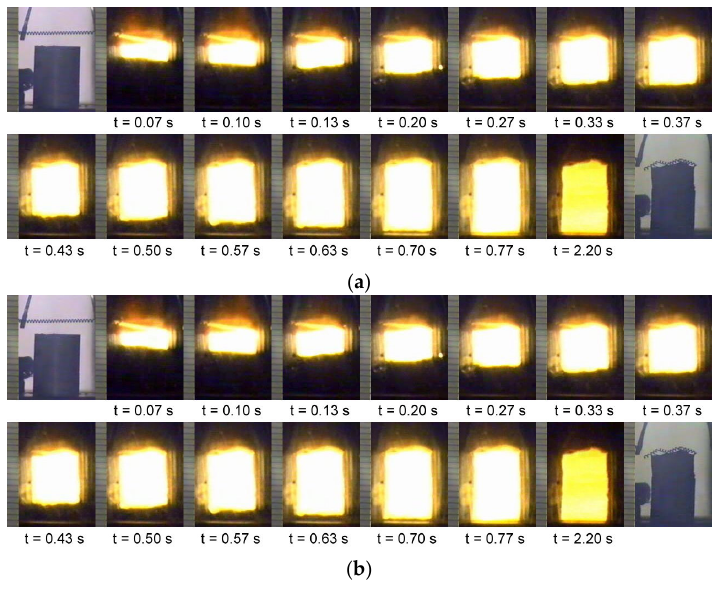
Figure 1. Time sequences of recorded images illustrating self-sustaining combustion propagating along powder compacts with stoichiometries of ( a ) 2.5Ti + B 4 C + 0.5Mo and ( b ) 2.1Ti + B 4 C + 0.9Cr.